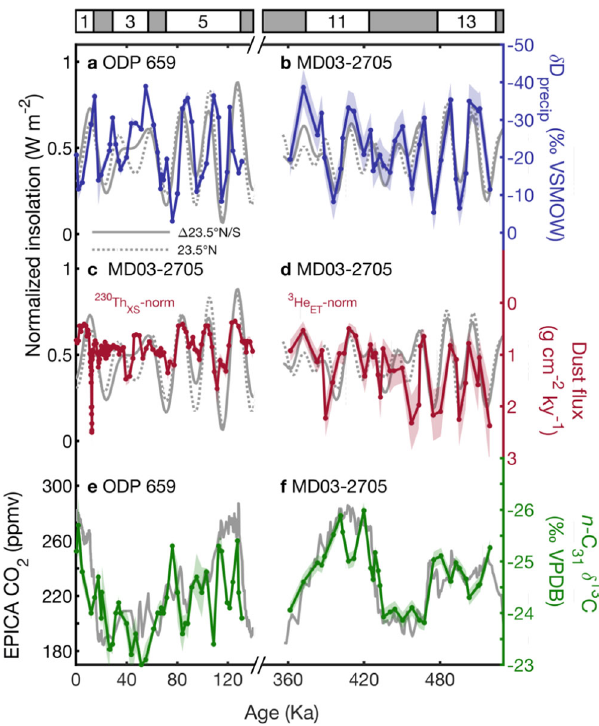
Fig. 3 Comparison between MIS 13-10 and the last glacial cycle. a δ D precip with 1 σ uncertainty (ref. 42 , blue line and shading) plotted with the normalized summer inter-hemispheric insolation gradient June 21 23.5°N – 23.5°S insolation (solid gray line) and the normalized local insolation June 21 23.5°N (dashed gray line), b δ D precip (this study) plotted as in a , c 230 Th XS -normalized dust fl ux with 1 σ uncertainty (ref. 20 , red line and shading) plotted with the summer inter-hemispheric insolation gradient June 21 23.5°N – 23.5°S insolation (gray line), d 3 He ET -normalized dust fl ux (this study) plotted as in c , e Plant-wax n -C 31 δ 13 C with 1 σ uncertainty (ref. 42 , green line and shading) plotted with EPICA ice core pCO 2 (ref. 128 , gray line), f δ D precip (this study) plotted as in c . Note that MIS 6-1 and 13 – 10 dust fl uxes use different methods that may have additional uncertainties when comparing them (see “ methods ” and Figs. S10, 11 for